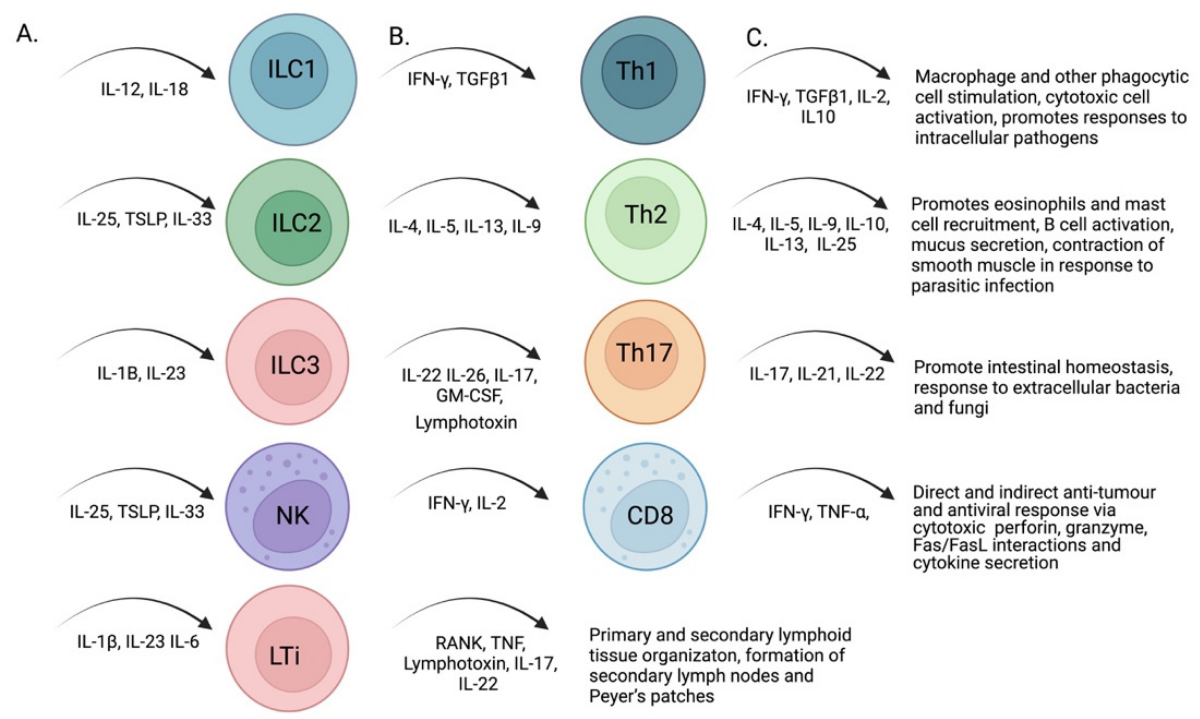
Figure 3. Actions of cytokines produced by innate lymphoid cells. Innate lymphoid cells respond to cytokine engagement ( A ) by producing additional cytokines that act directly on T cells ( B ), to promote additional cytokine production as well as influence their effector function ( C ) [105].